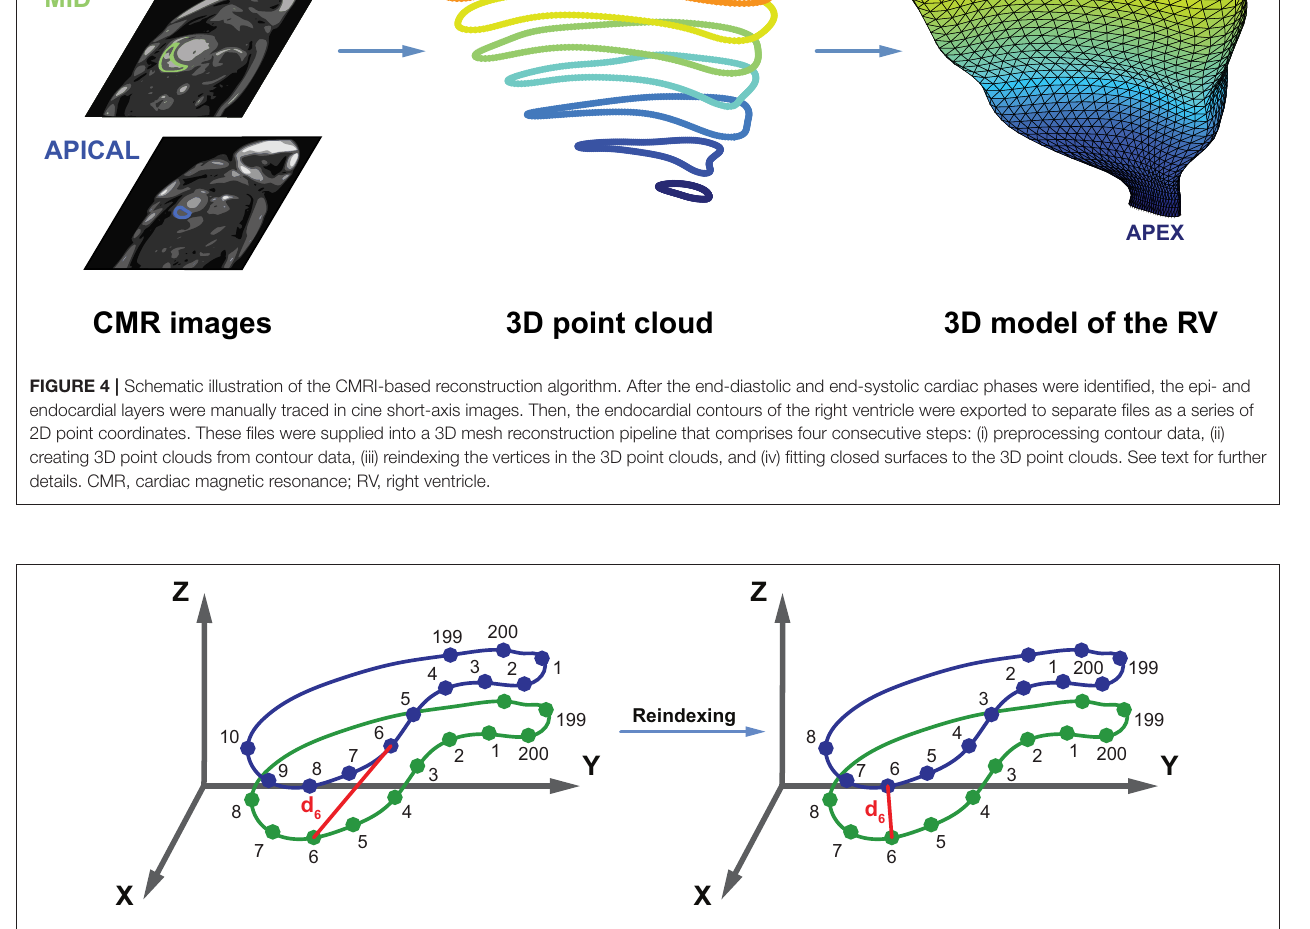
FIGURE 5 | Schematic illustration of the reindexing step. The green and blue contours represent two slices containing equal number ( n = 200) of points. The vertices of the blue contour are reindexed in a way that the mean squared error between the corresponding vertices of the green and blue contours becomes minimal. With appropriate reindexing, a vertex with a given index is located approximately at the same anatomical position in both contours. See text for further details. d 6 , the distance between the points with the index 6 of the two contours.